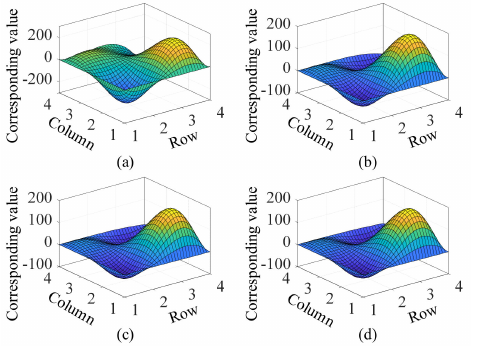
Figure 18. State matrixes on different longitudinal speeds: ( a ) v x = 1 m/s; ( b ) v x = 10 m/s; ( c ) v x = 20 m/s; ( d ) v x = 30 m/s.